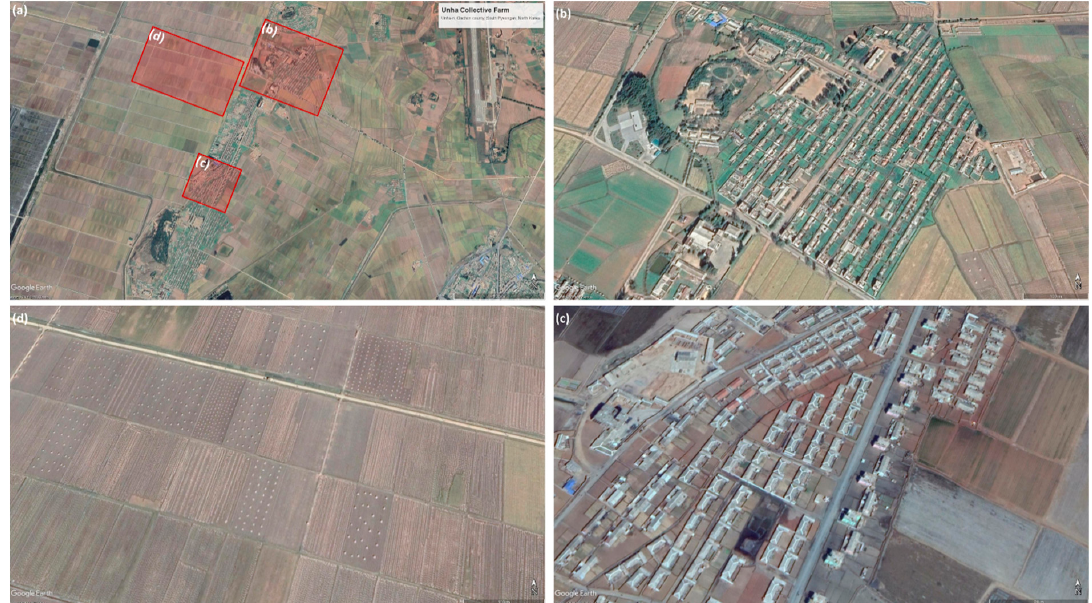
Figure 3. Spatial characteristics of cooperative farmlands extracted from high-resolution EO data. ( a ) stands for the Unha collective farmlands surrounded by (dry) paddy-fields (georeferenced: Onchon county, South Pyeongan); ( b ) represents planned spatial arrangements and a centralized cluster of buildings and dwellings; ( c ) highlights buildings and houses utilize homogeneous materials and retains its similar physical shapes and simple roof structures; ( d ) includes textures of irrigation channels and features of rice (dry) paddy-fields. (Image sources: Google Earth, date of access: 9 October